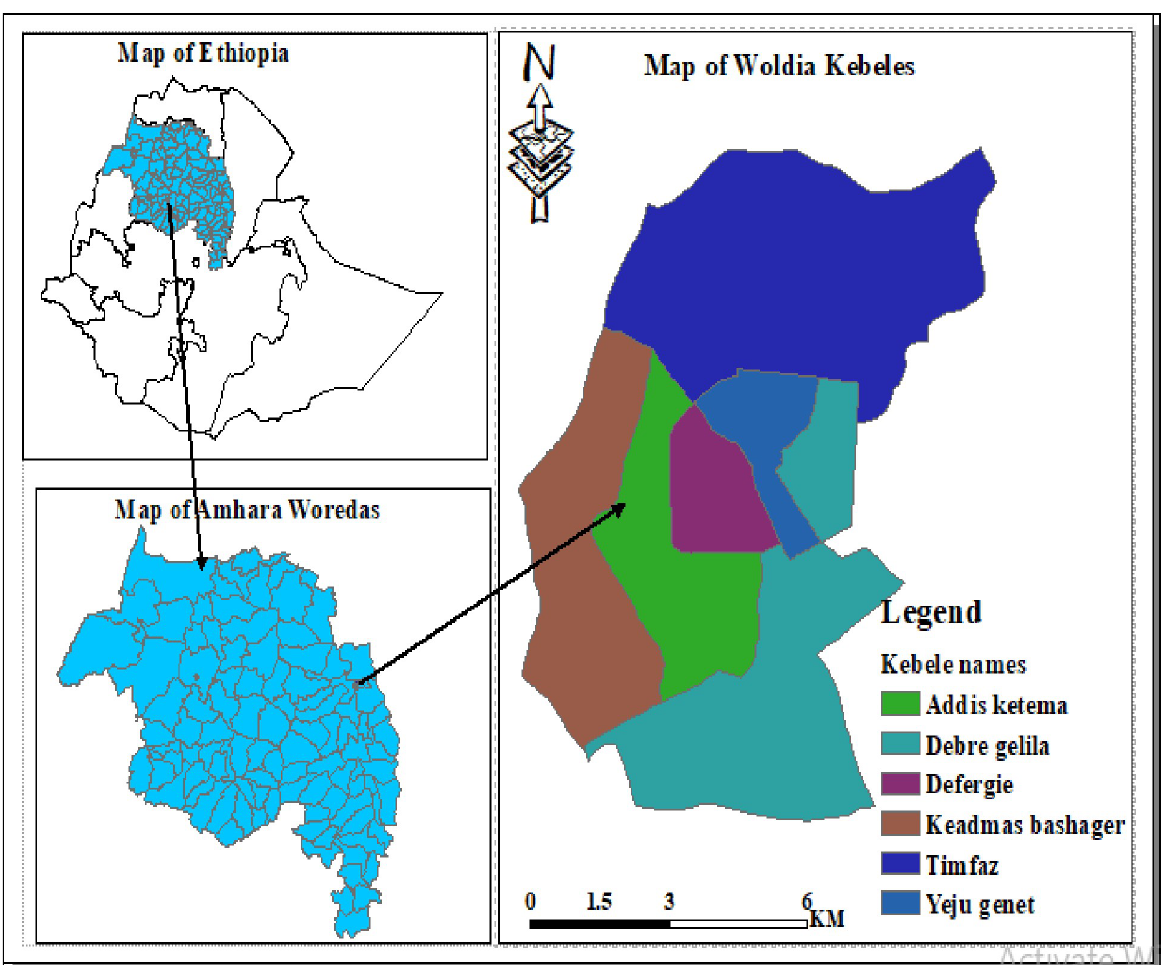
Fig 1. Map of the study area. Source: www.diva-gis.org/gdat.